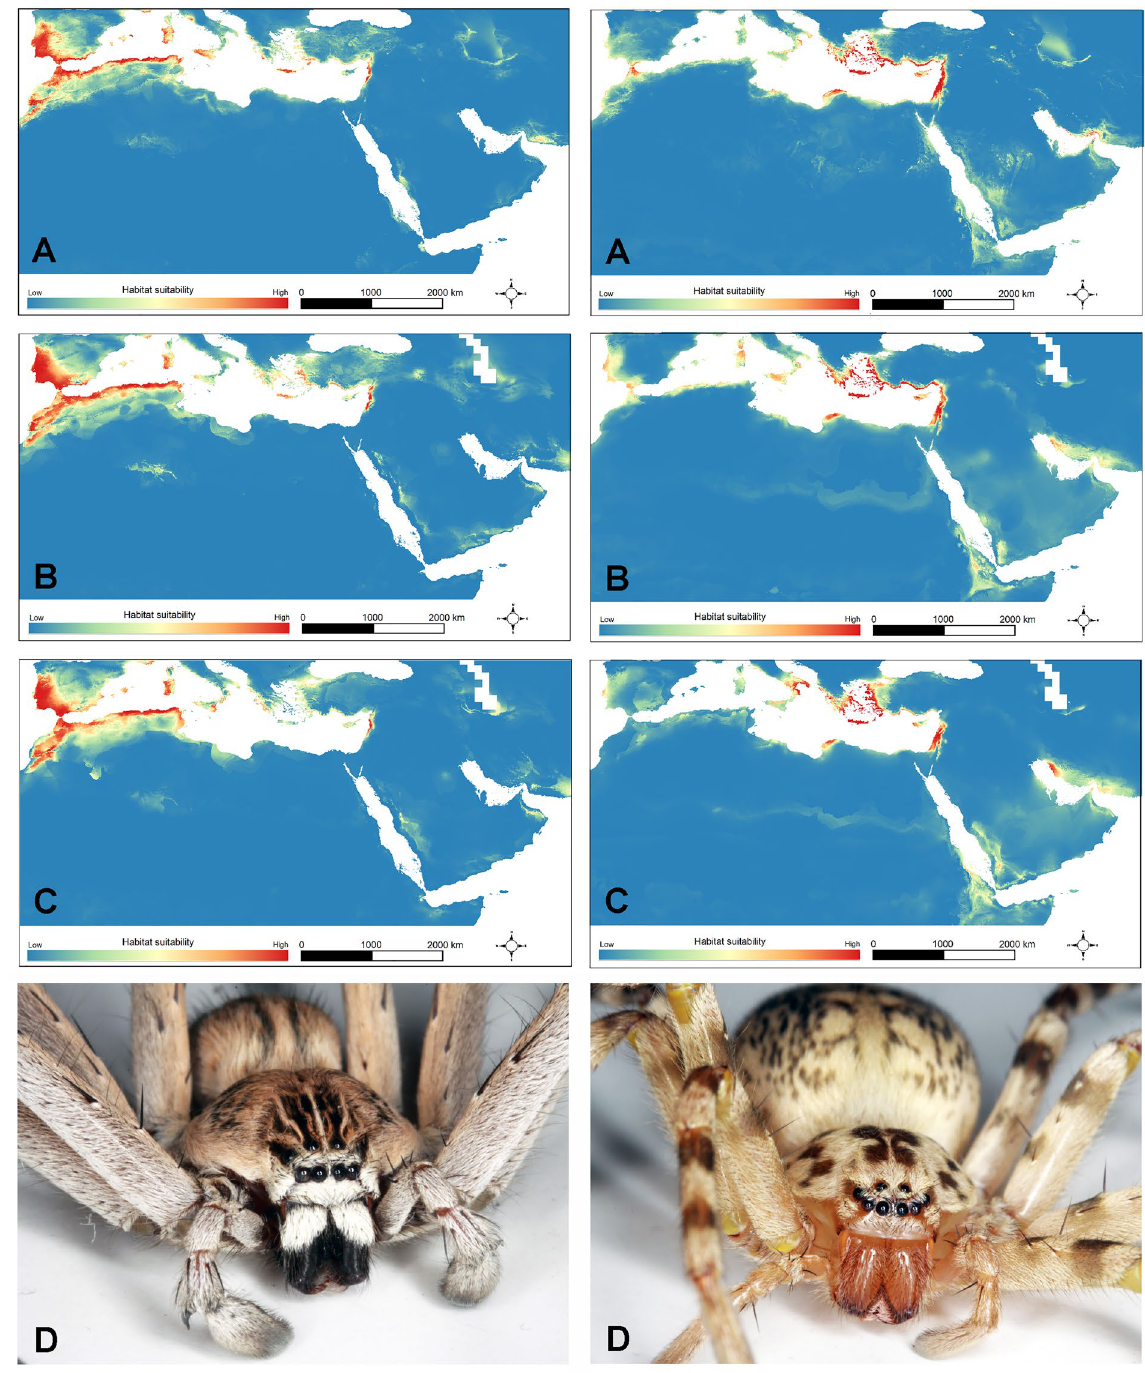
Figure 5. Climate suitability maps for the dufouri clade (left) and walckenaeri clade (right) for current ( A ) and future climate (2070), under CCSM4 RCP 8.5 ( B ) and MIROC5 RCP 8.5 ( C ), representatives of each clade, habitus from frontal view ( D ). The suitability maps were created using Maxent software 3.4.1 (http:// biodi versi tyinf ormat ics. amnh. org/ open_ source/ maxent/) and mapped in QGIS 3.22.3 (https:// www. qgis. org). The spiders were photographed by Majid